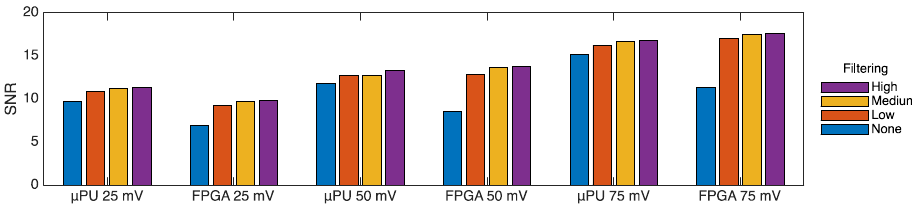
Figure 3. Signal-to-noise ratio for both systems at a range of signal amplitude and DSP filtering levels.